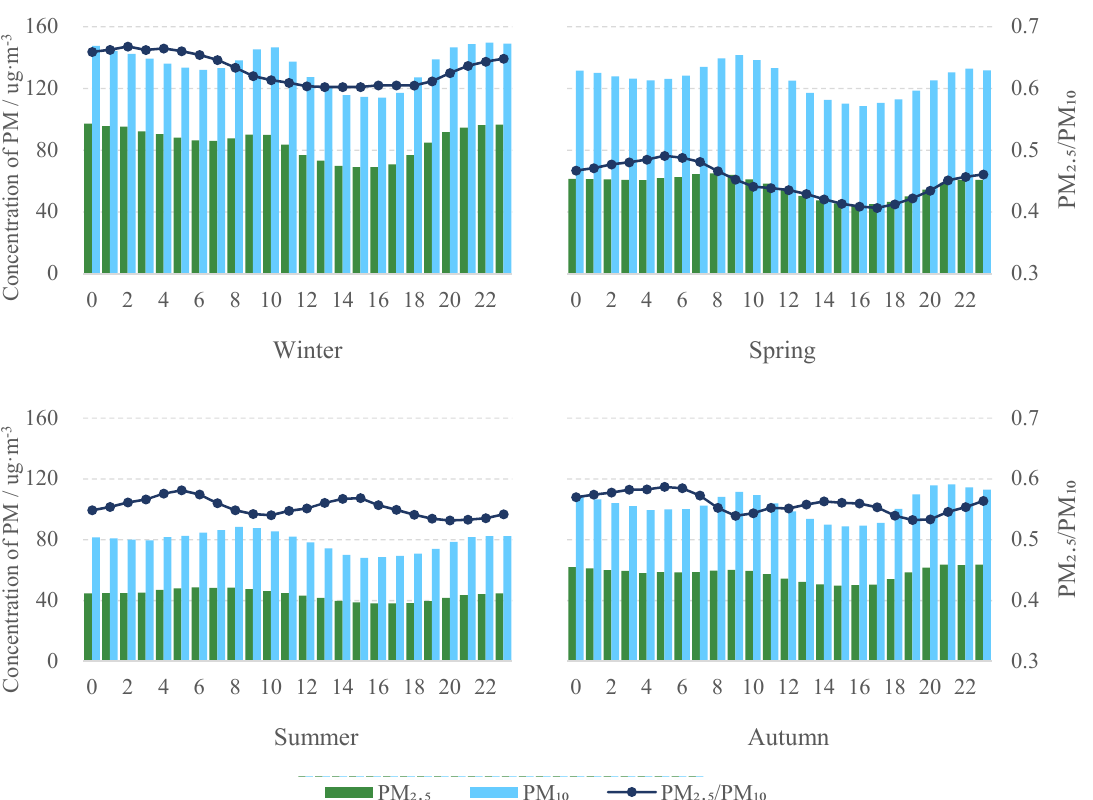
Figure 11. Temporal variation in the hourly mean value of atmospheric particulate matter concen ‐ tration.